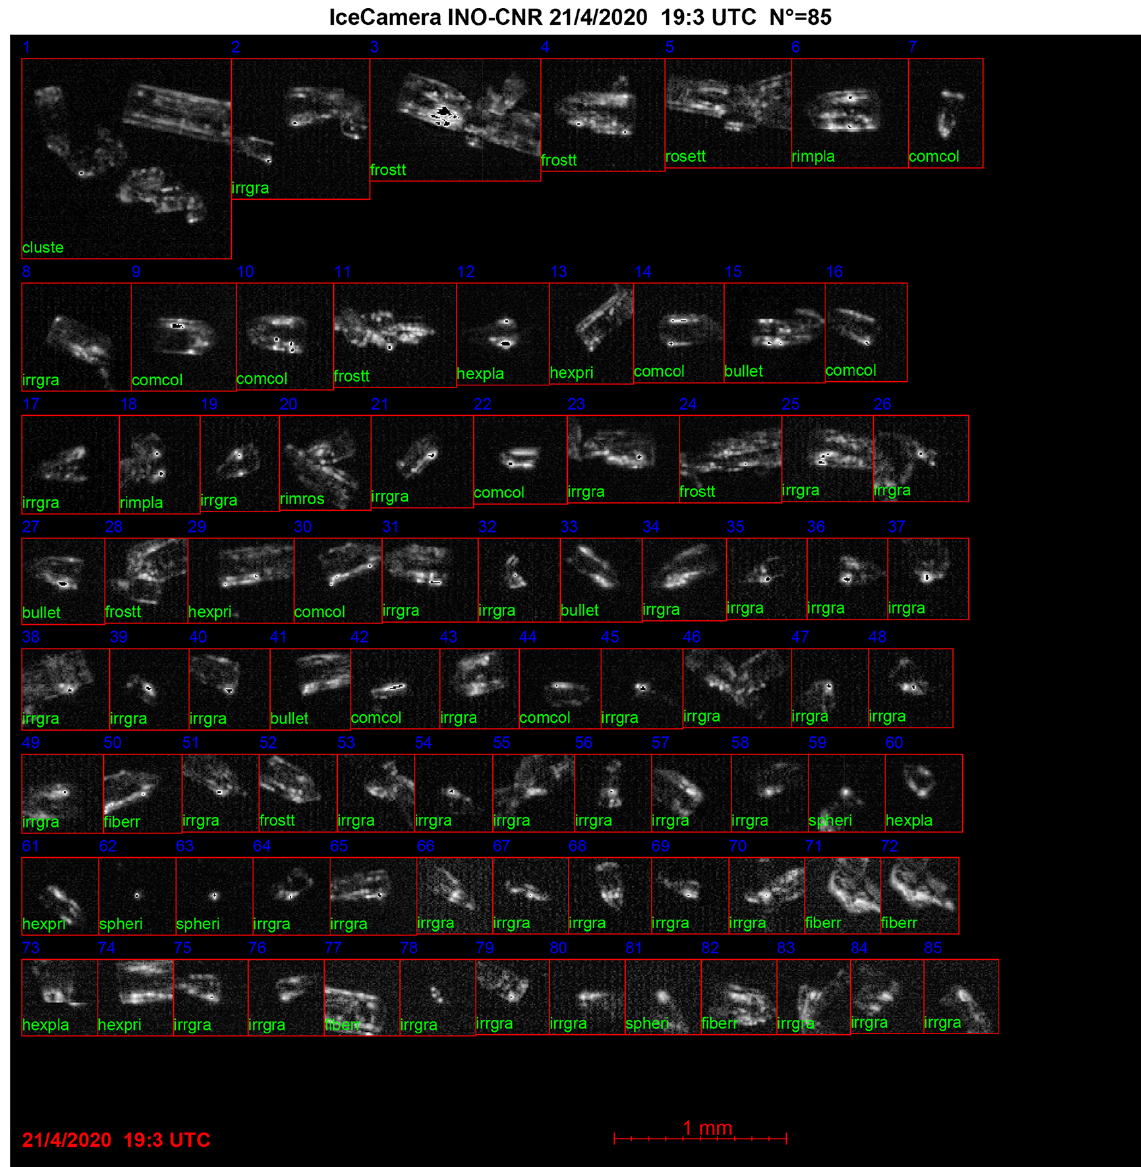
Figure 25. As for Fig. 20, but for the day of 21 April 2020 at 19:03UTC. At this time, complex aggregates of crystals are also